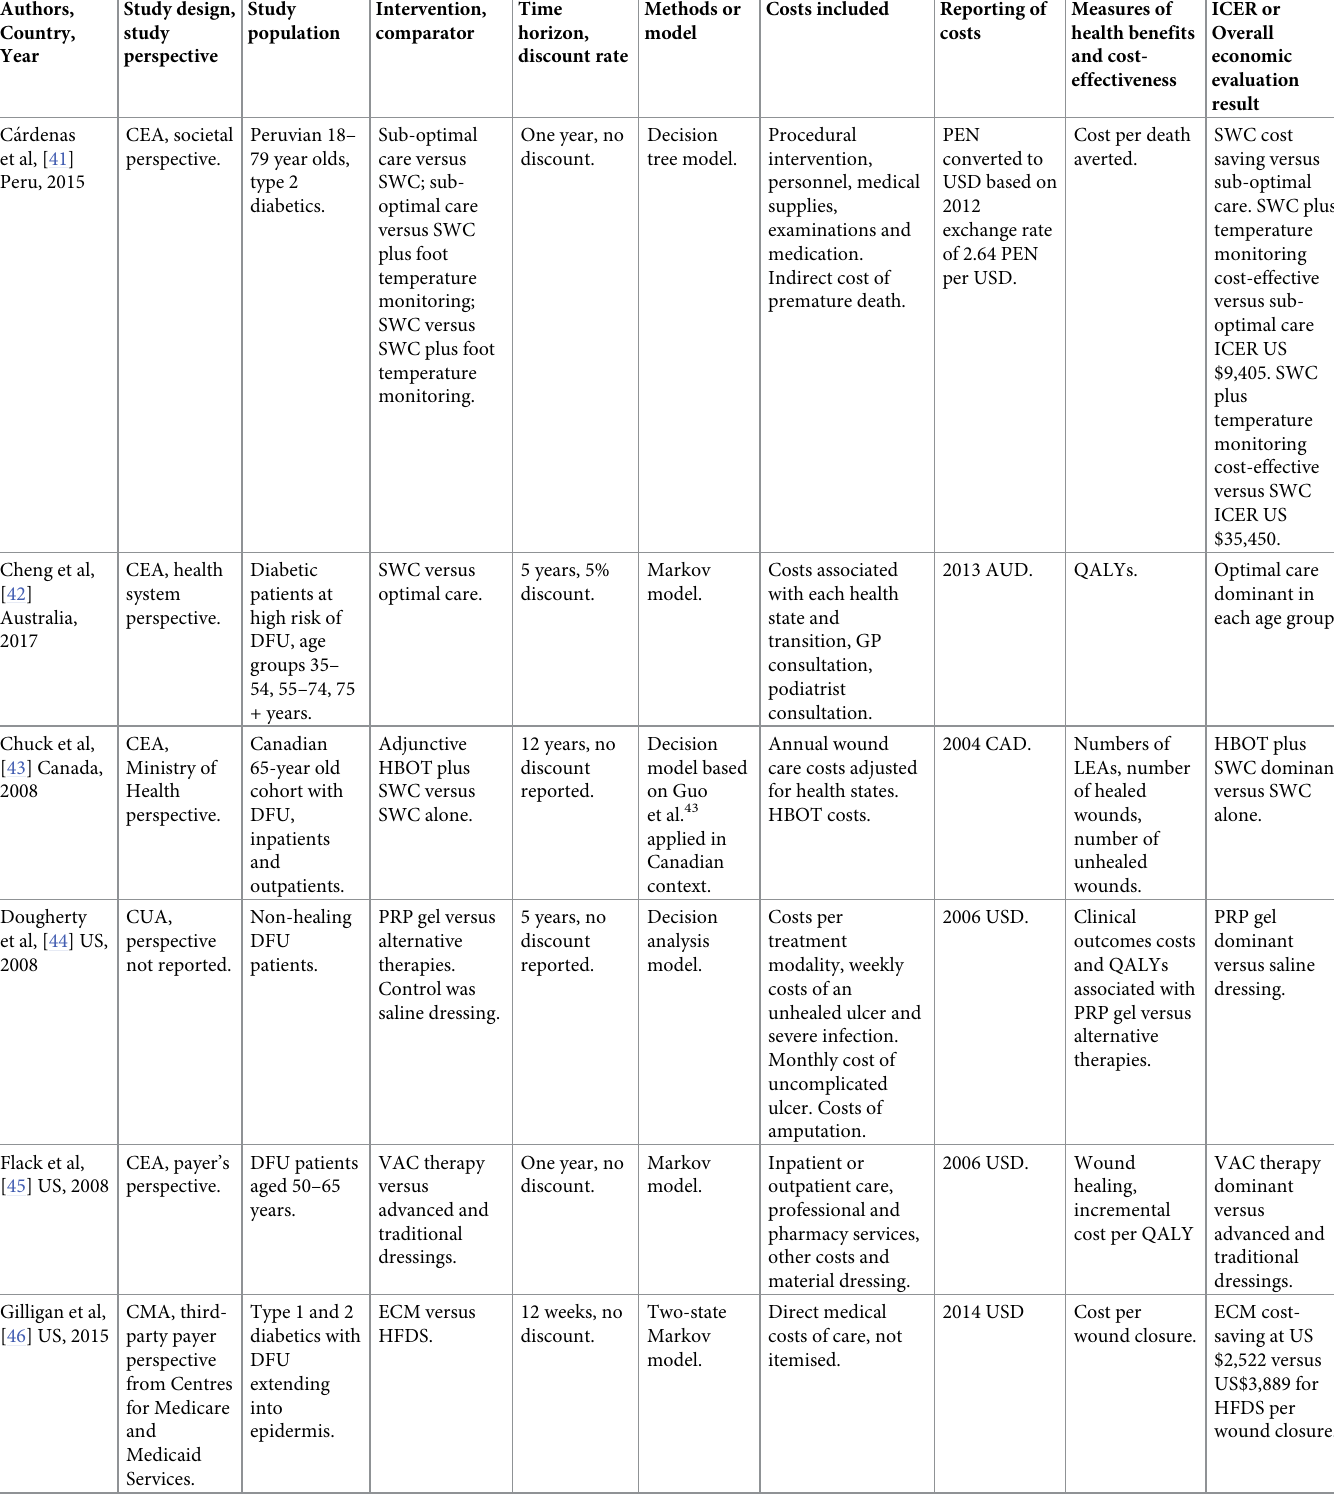
Table 2. Study results—Summary of economic evaluations of diabetic foot ulcer infections. Authors,